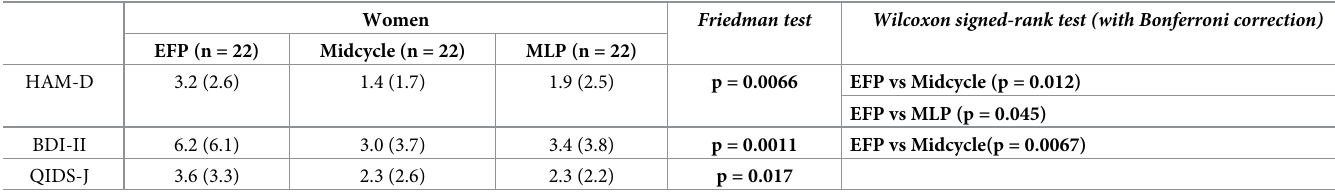
Table 2. Scores on depression rating scales during the menstrual